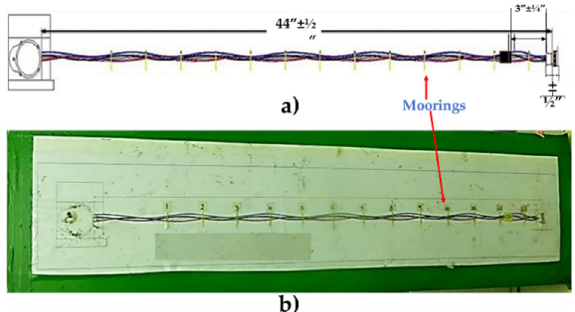
Figure 7. Template of the drawing provided by the customer: ( a ) picture of the template made in AutoCAD; ( b ) picture of the printed template.